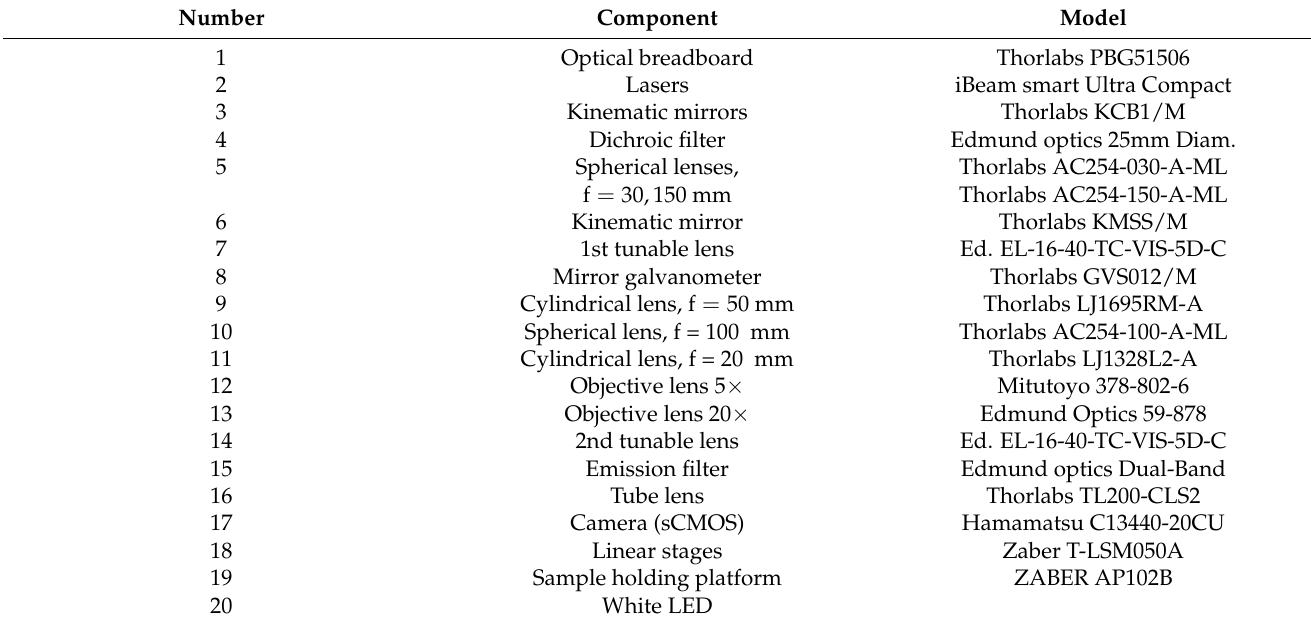
Table 1. Components and models of the SPIM system in Figure